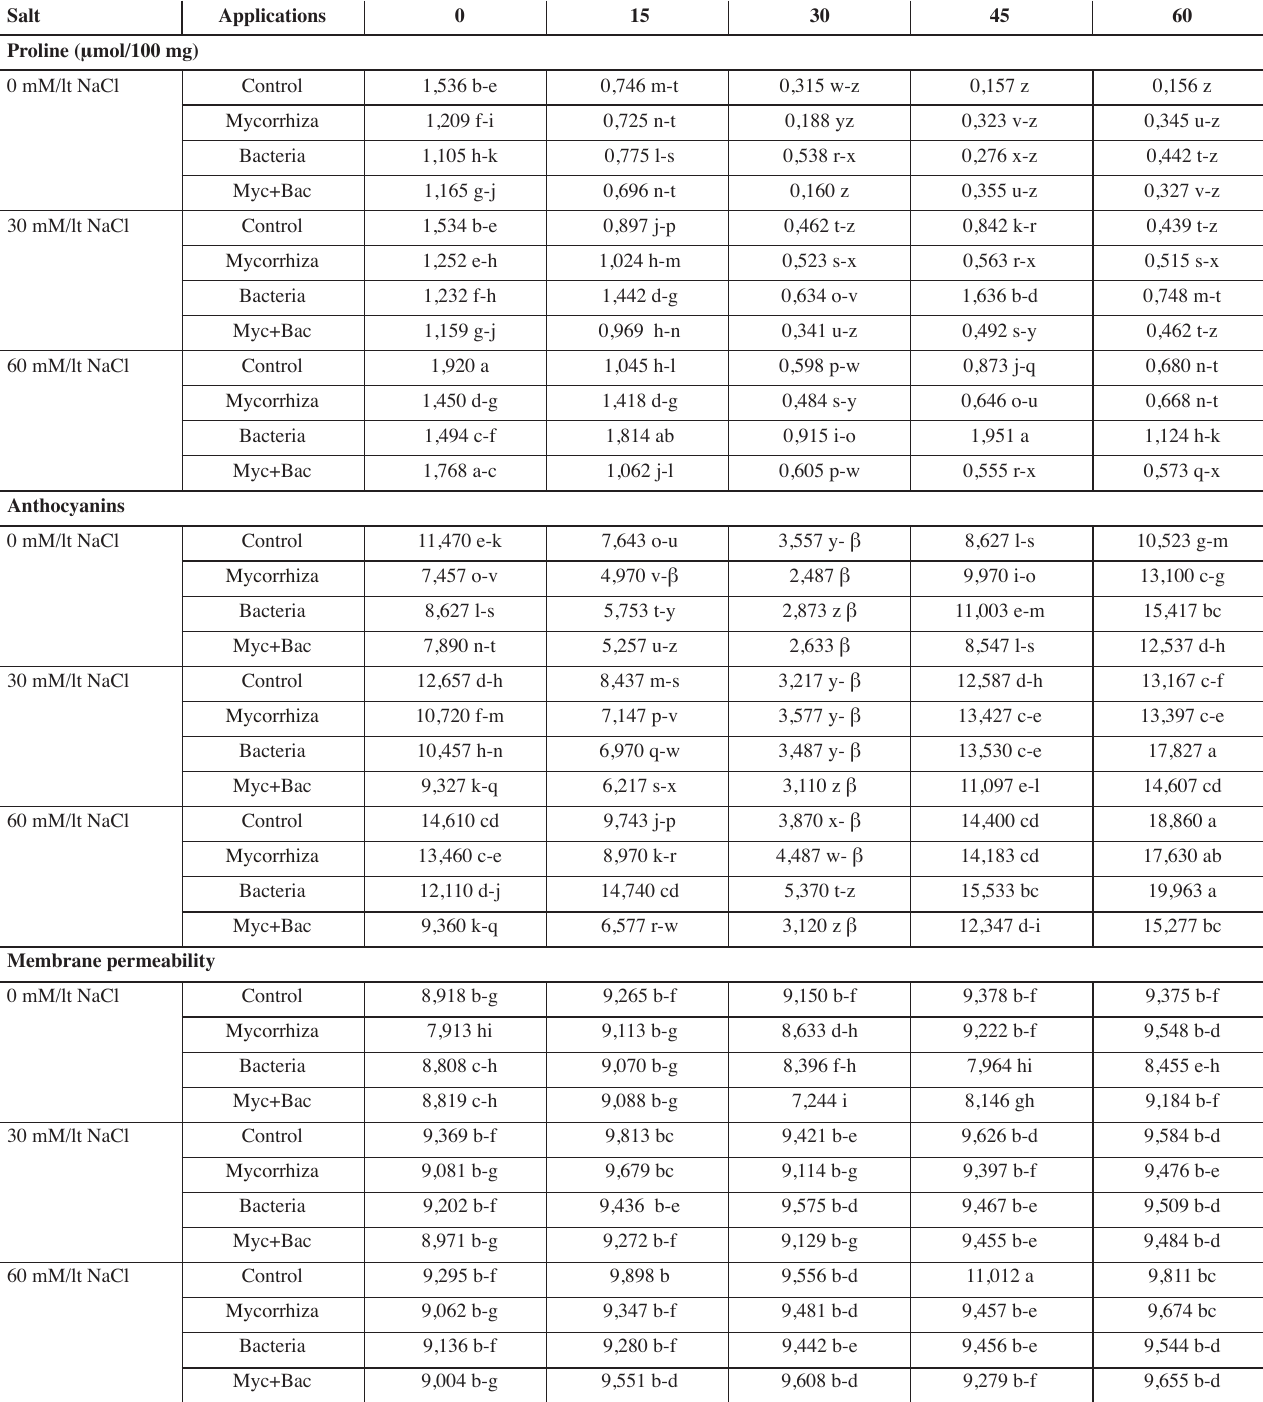
Tab. 4: Proline, anthocyanins and membrane permeability in the leaf tissues of strawberry cv. ‘San Andreas’ plants under salt (0, 30 and 60 mM/L NaCl) stress and applications (control, mycorrhiza, bacteria and myc+bac) for the periods of 0, 15, 30, 45 and 60 days.